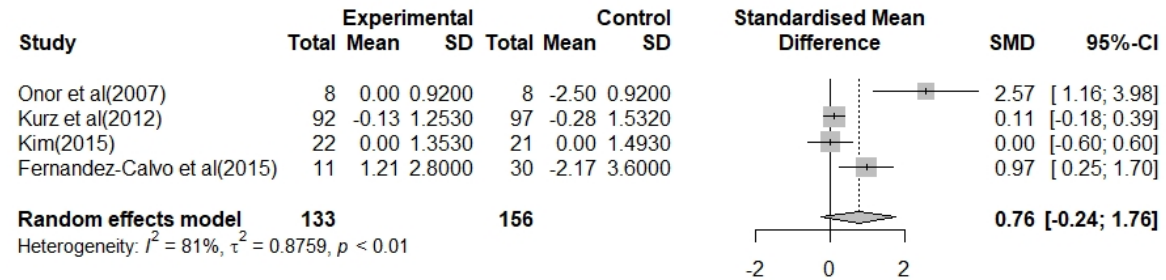
Figure 4. Forest plot for the effects of the multimodal occupational therapy program with cognition-oriented approach on BADL in patients with AD.